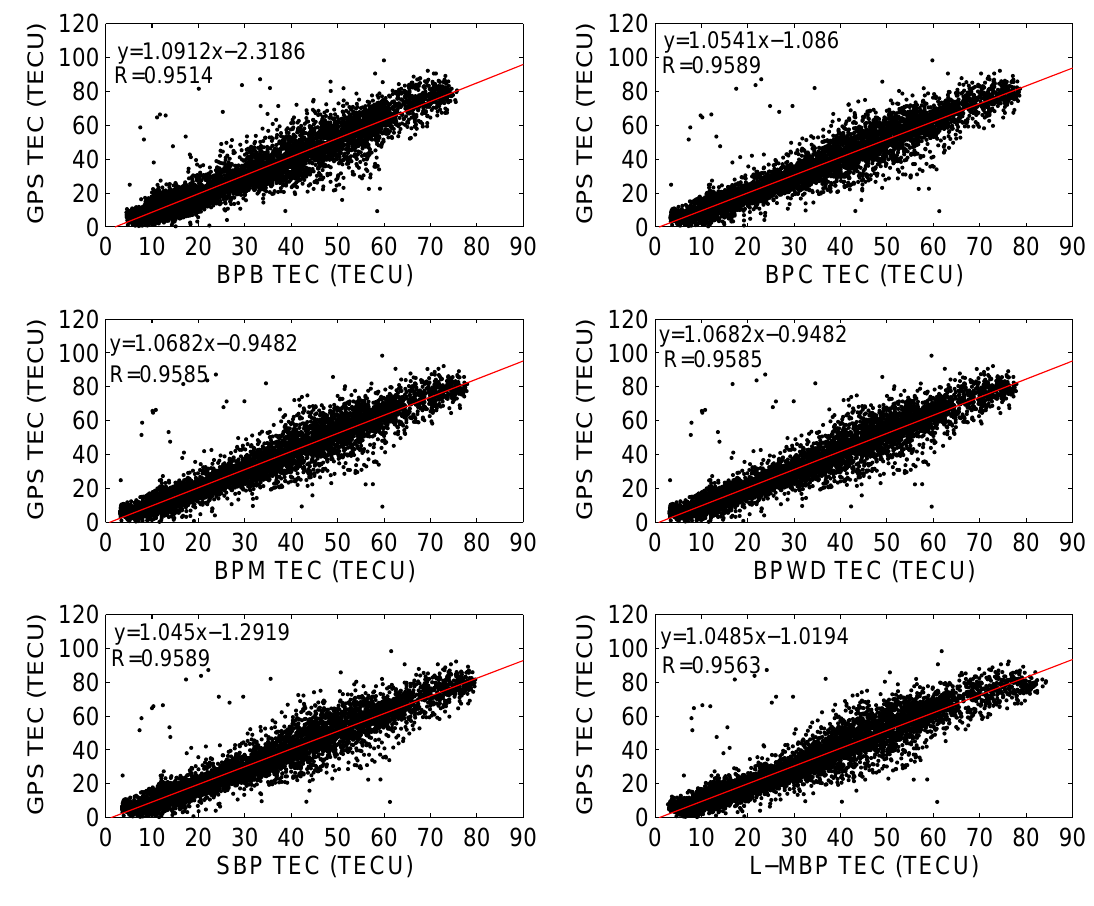
Fig. 3. Similar to Fig. 1, but for Cape Town in 2002.